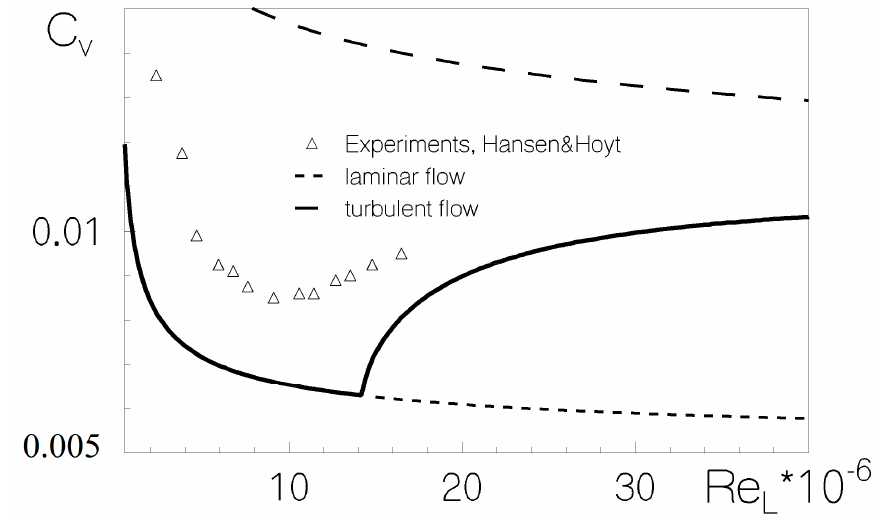
Figure 3. Drag coe ffi cient estimations for a body of revolution similar to the shape of Dolphinus delphis Figure 3. Drag coefficient estimations for a body of revolution similar to the shape of Dolphinus ponticus Barab. (L / D = 4.76) and comparison with the experimental measurements of drag on the delphis ponticus Barab. (L/D = 4.76) and comparison with the experimental measurements of drag Hansen and Hoyt model on the Hansen and Hoyt model [31].